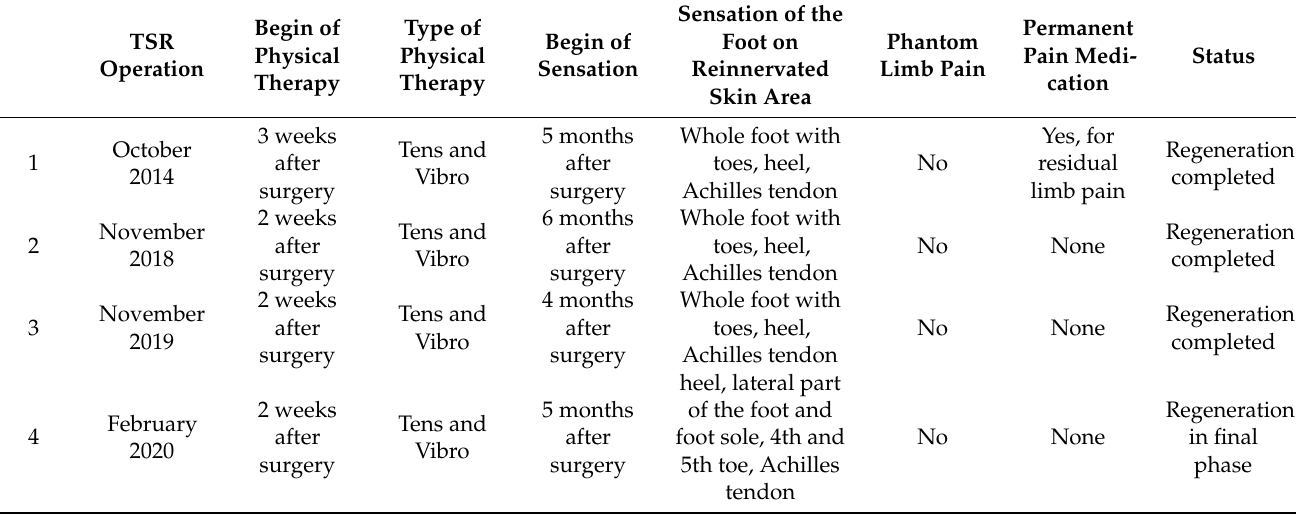
Table 2. Summary of post-operative